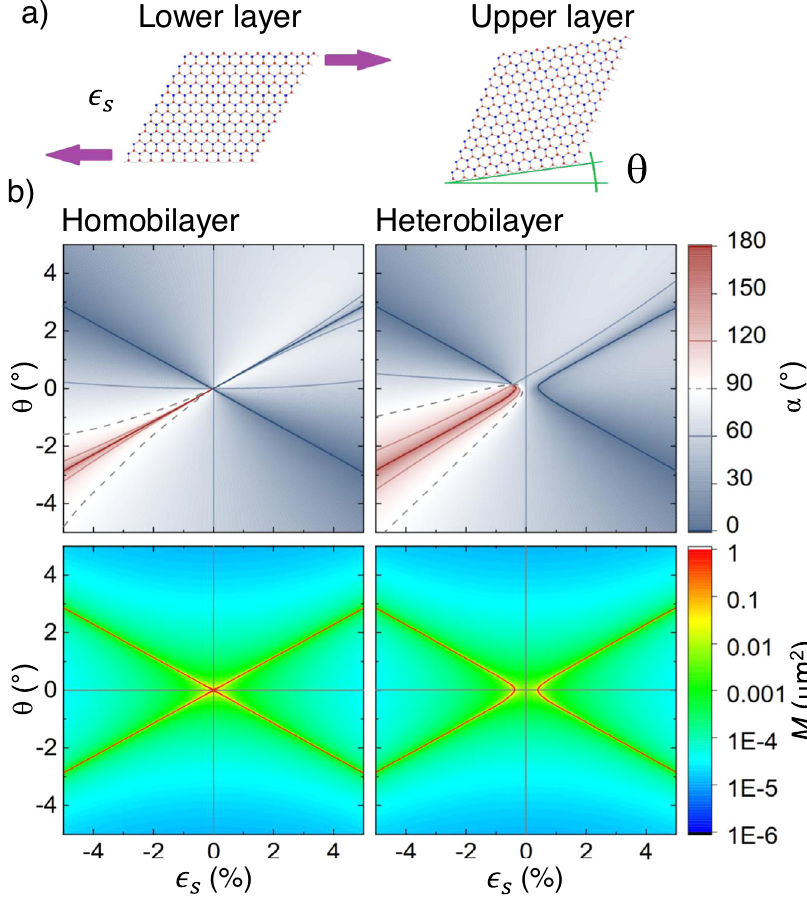
Fig. 5 Moiré lattice deformation in hexagonal bilayers under shear heterostrain. a Scheme of the moiré lattice formation under shear heterostrain ϵ s . The deformation of the lower layer due to shear strain along the zigzag direction is depicted through arrows. The upper layer was stacked with an angle θ respect to the lower one. b Relative angle α (upper panels) and moiré lattice area M (lower panels) as a function of shear strain ϵ s and stacking angle θ for homobilayer (left panels) and heterobilayer (right panels) systems. Gray dotted lines denote con fi gurations in which the moiré lattice is rectangular ( α =